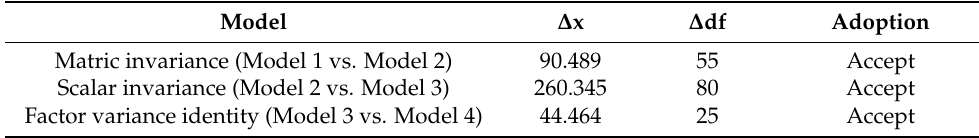
Table 4. χ 2 results for latent mean analysis. Model Matric invariance (Model 1 vs. Model 2) Scalar invariance (Model 2 vs. Model 3) Factor variance identity (Model 3 vs. Model